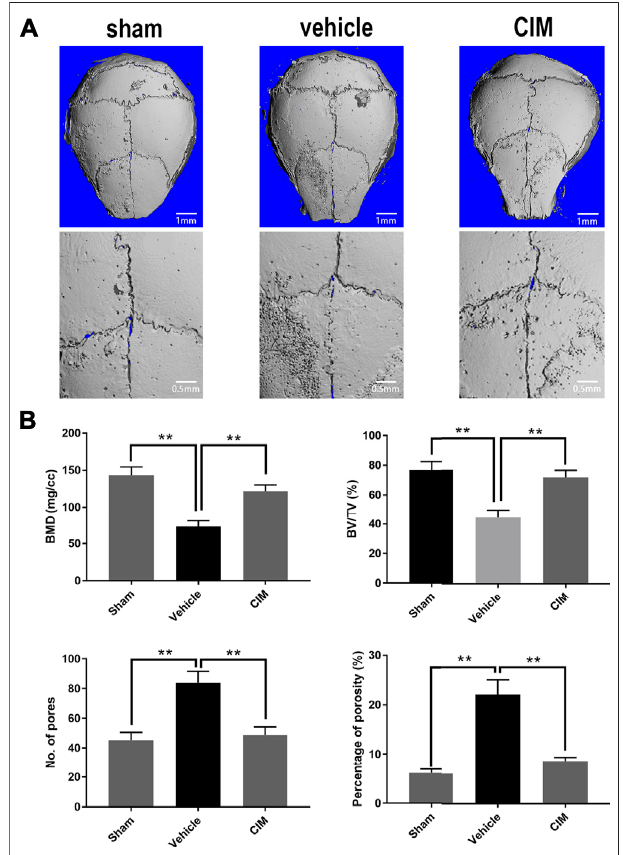
FIGURE 5 | CIM protects murine calvaria from Ti particle-induced osteolysis in vivo . (A) Reconstructed micro-CT radiograph of harvested murine calvaria. (B) The bone mineral density (BMD), bone volume versus tissuevolume (BV/TV), number ofpores and percentage oftotal porosity withinregionsofinterestwereanalyzed.(**: p <